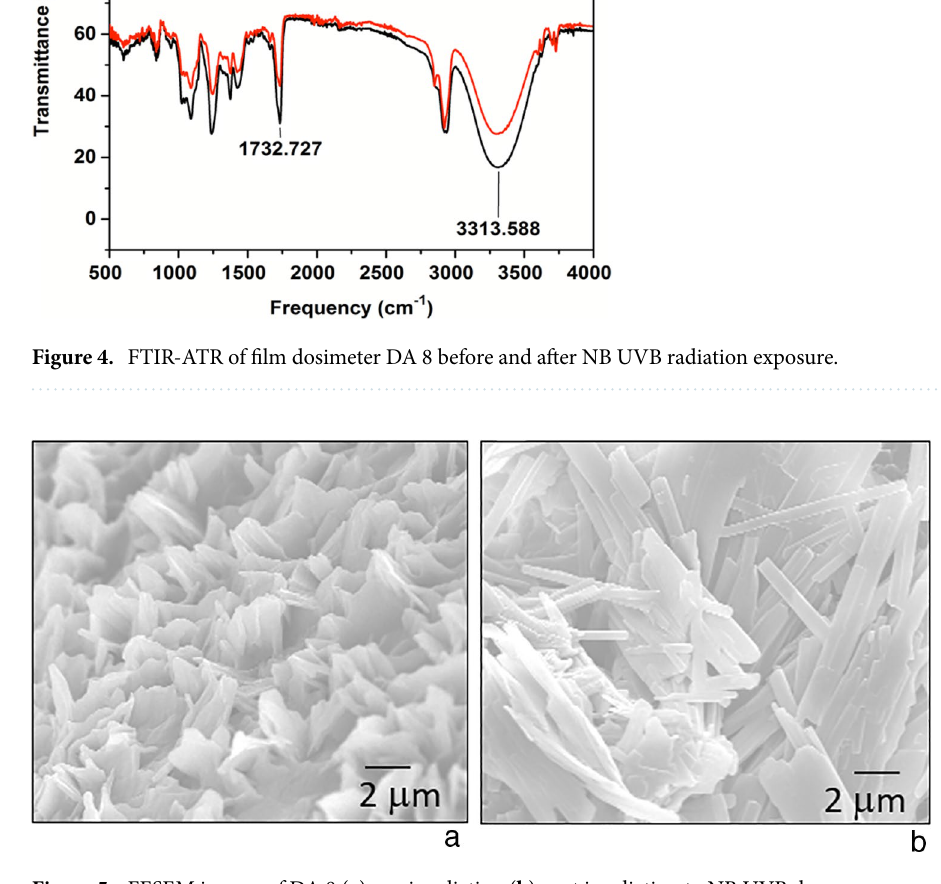
Figure 5. FESEM images of DA 8 ( a ) pre-irradiation ( b ) post irradiation to NB UVB